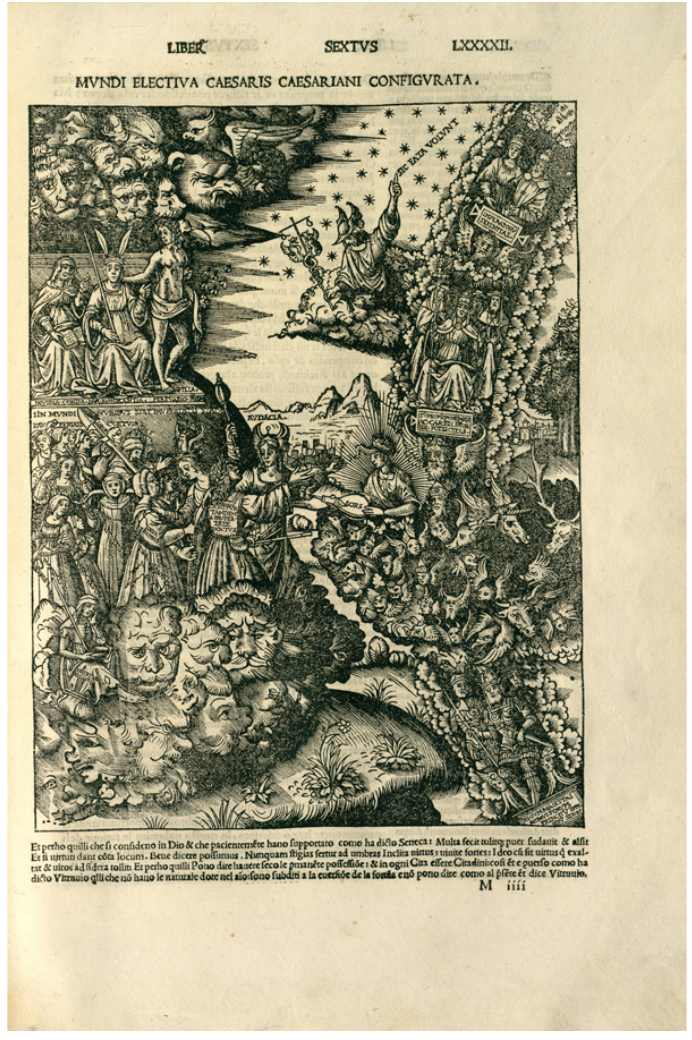
Figure 7. Cesare Cesariano, Allegory of His Life. From Cesare Cesariano, Di Lucio Vitruvio Pollione de architectura … (Como, 1521) Book 6, folio LXXXXII verso.